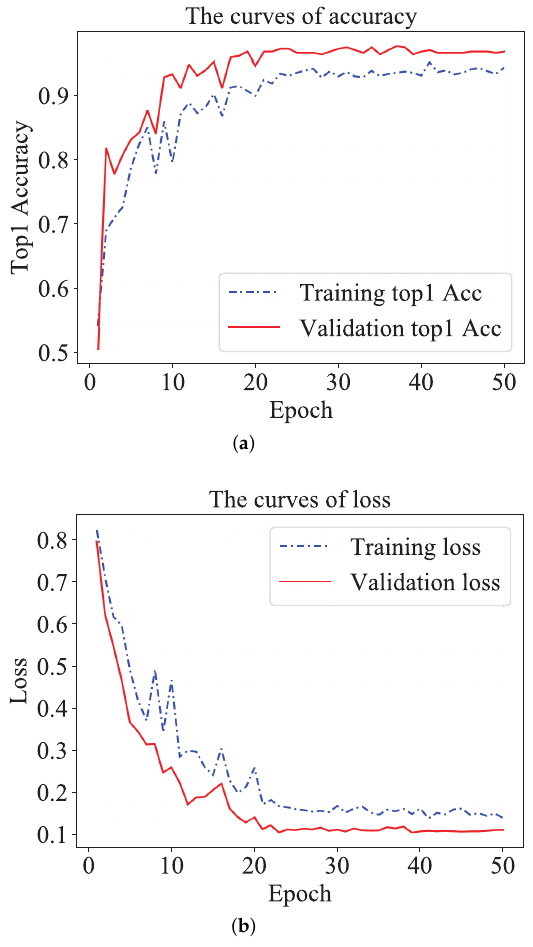
Figure 8. The loss and accuracy curves during training. ( a ) the curves of Top1 accuracy, ( b ) the curves of loss.